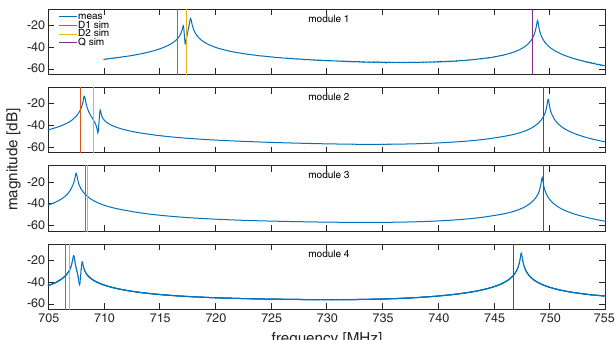
FIG. 6. Comparison of measurements (blue) and simulations of the frequency of the first three modes of the four single modules.